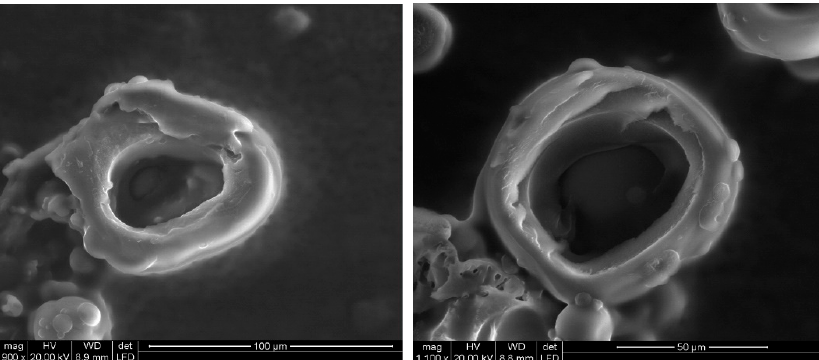
Figure 5. Cross-section of VIPS capsules. Processes 2019 , 7 , x FOR PEER REVIEW